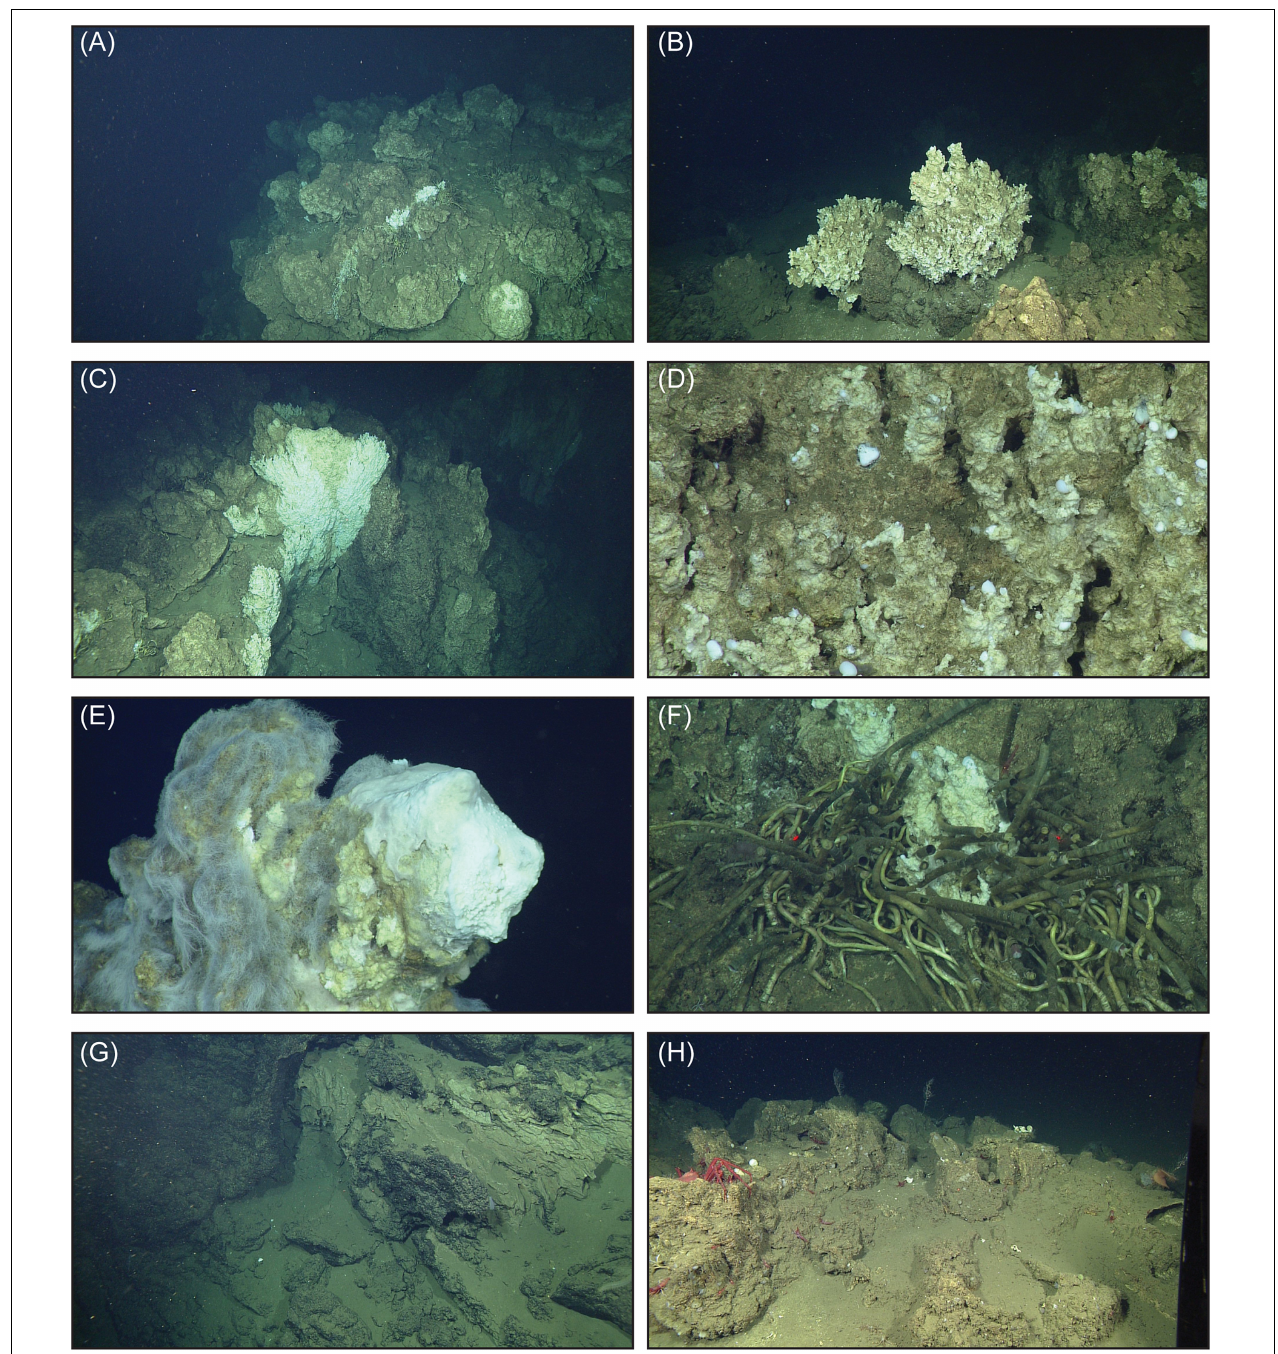
FIGURE 5 | Images collected during ROV dives DR767 and DR769 on the San Clemente Fault and San Diego Trough Fault, respectively. (A,B) Barite mounds of presumably different ages as indicated by the accumulation of a muddy drape. (C) Barite “heads” with spires ending in “fingers,” growing from the sides and top of a barite mound. (D) Bacterial mats growing at the ends of barite “fingers.” (E) Filamentous and gelatinous bacterial mats fully covering a barite “head.” (F) Barite precipitates engulfing live Lamellibrachia tubeworms. Red dots are laser beams separated by 29 cm. (G) Sub-horizontal layers of cemented drape intercalated with barite deposits. To the left a barite deposit is draped over the cemented strata. (H) Barite deposit found near the San Diego Trough Fault.